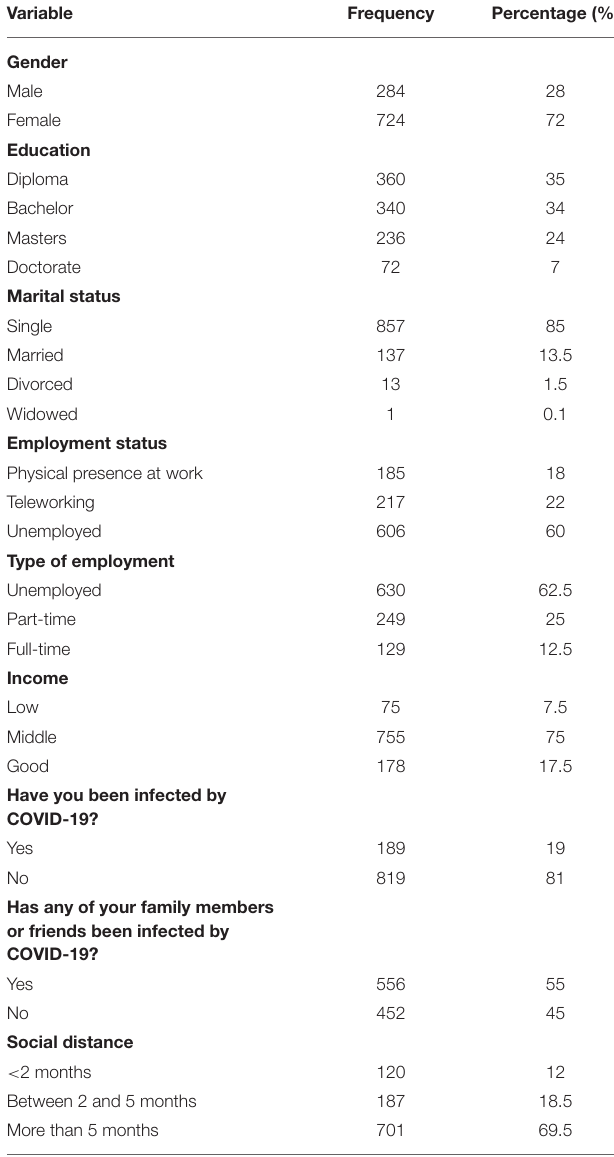
TABLE 1 | Demographic characteristics of study sample ( n =